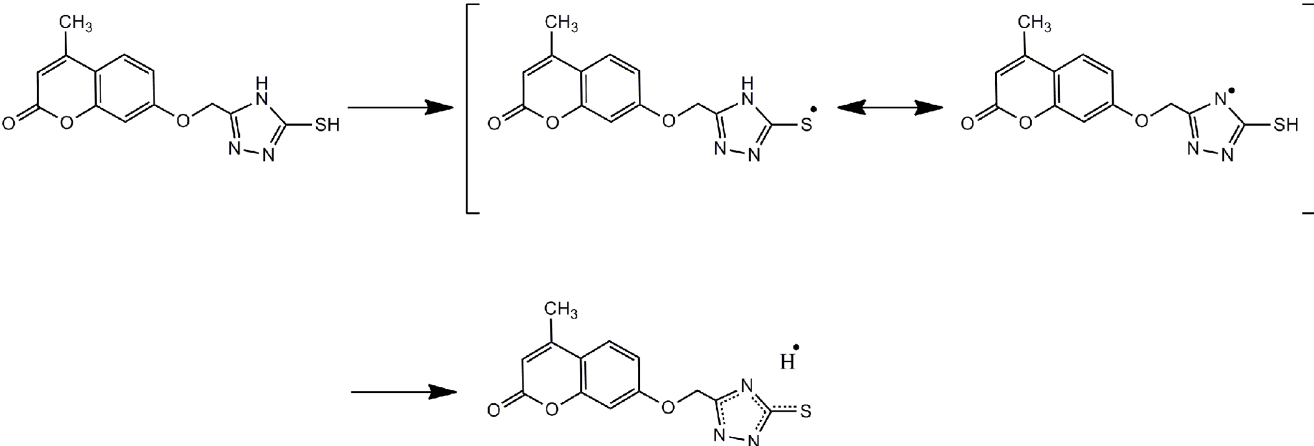
Fig 3. Suggested mechanism for compound 4 as an antioxidant.